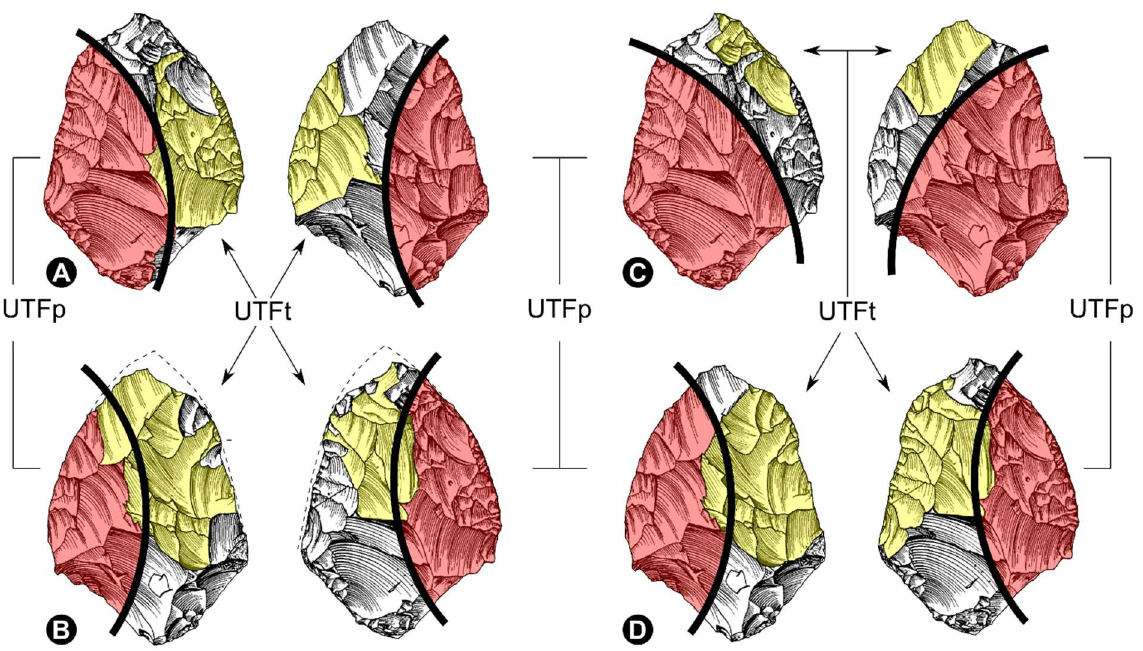
Figura12. Determinación de las unidades técnico-funcionales en la estructura de la pieza bifacial de la capa C’3 base del sitio de Barbas I, Dordoña. En rojo, la zona funcional con rol prehensivo (UTFp); en amarillo, la zona funcional con rol transformativo (UTFt). La relación de las dos UTF, evaluada a nivel individual y a nivel del conjunto lítico, permitió identificar cuatro útiles (A-D) presentes en una sola pieza bifacial. Como es evidente, algunas zonas tienen una doble función dentro de la misma estructura (Modificado de Boëda 2001: 72, figs 16-